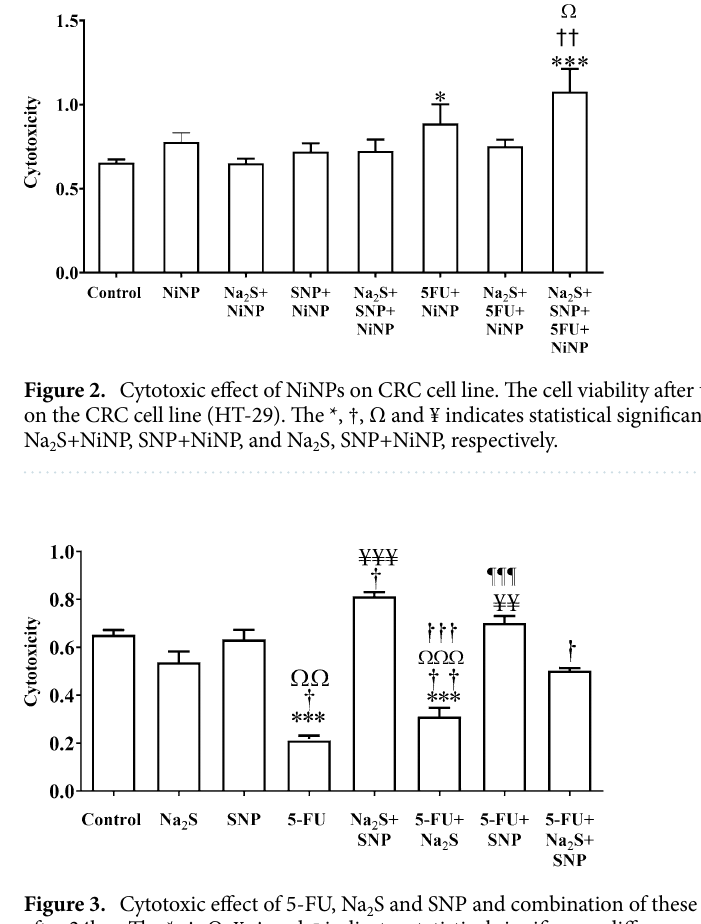
Figure 3. Cytotoxic effect of 5-FU, Na 2 S and SNP and combination of these treatment on CRC cell line (HT-29) after 24hrs. The *, †, Ω, ¥, † and ¶ indicates statistical significance difference from control, Na 2 S, SNP, 5-FU, Na 2 S and SNP, and 5-FU and Na 2 S,